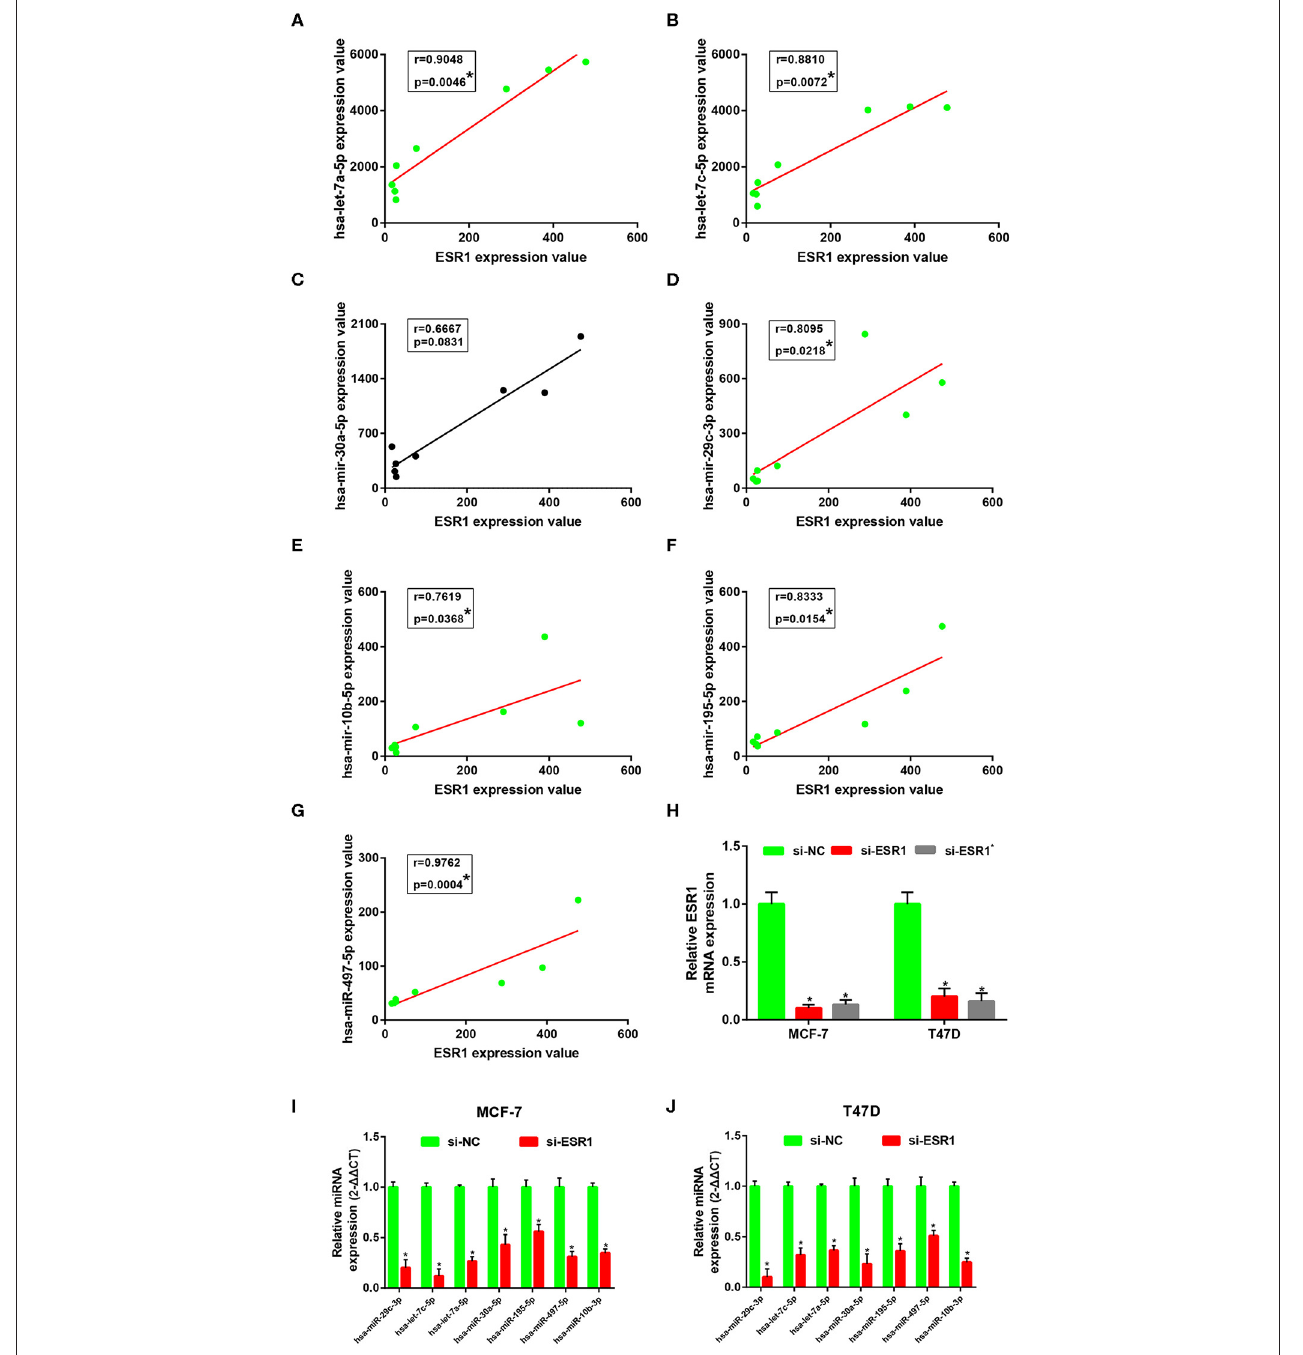
FIGURE 6 | ESR1 positively regulate 7 key miRNAs in ER α positive breast cancer. (A) The correlation analysis of ESR1 expression and hsa-let-7a-5p expression. (B) The correlation analysis of ESR1 expression and hsa-let-7c-5p expression. (C) The correlation analysis of ESR1 expression and hsa-miR-30a-5p expression. (D) The correlation analysis of ESR1 expression and hsa-miR-29c-3p expression. (E) The correlation analysis of ESR1 expression and hsa-miR-10b-5p expression. (F) The correlation analysis of ESR1 expression and hsa-miR-195-5p expression. (G) The correlation analysis of ESR1 expression and hsa-miR-497-5p expression. “*” represented significant correlation, with P < 0.05. (H) Knockdown effect of ESR1 siRNAs in MCF-7 and T47D cell lines. (I) Expression change of 7 key miRNAs after silencing expression of ESR1 in MCF-7 cell line. (J) Expression change of 7 key miRNAs after silencing expression of ESR1 in T47D cell line. The data were shown as mean ± standard deviations. “*” represented significant difference, with P < 0.05.